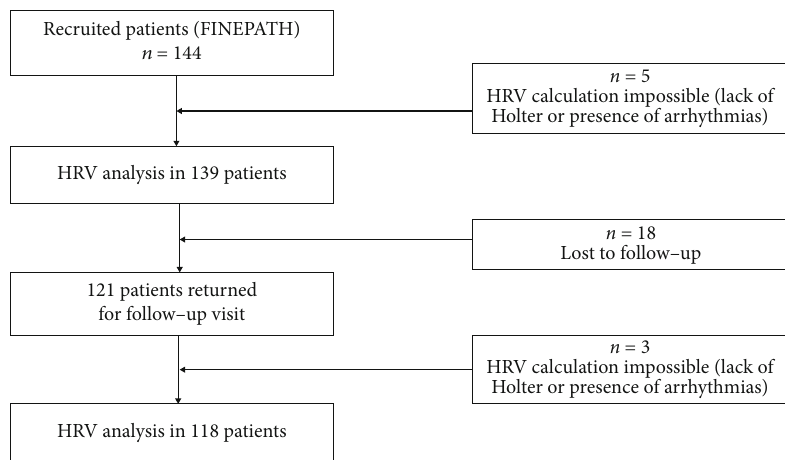
Figure 1: Study patient fl ow